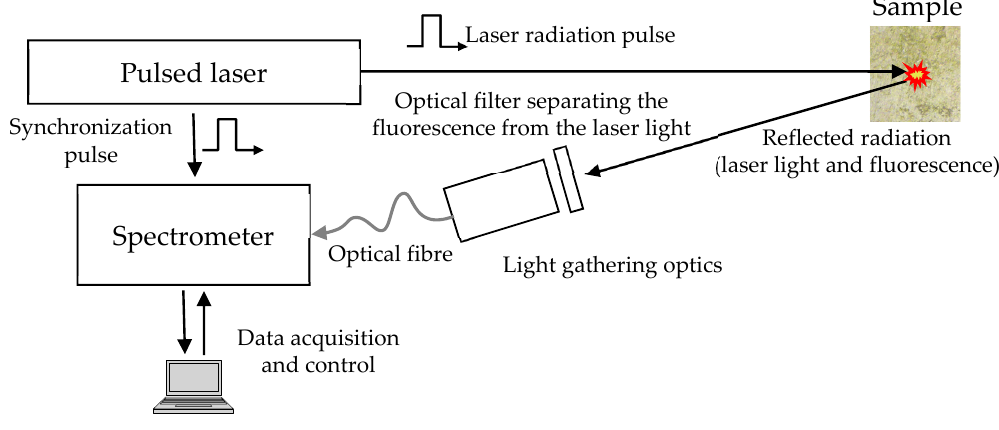
Figure 1. Setup for laser-induced fluorescence (LIF) measurements.